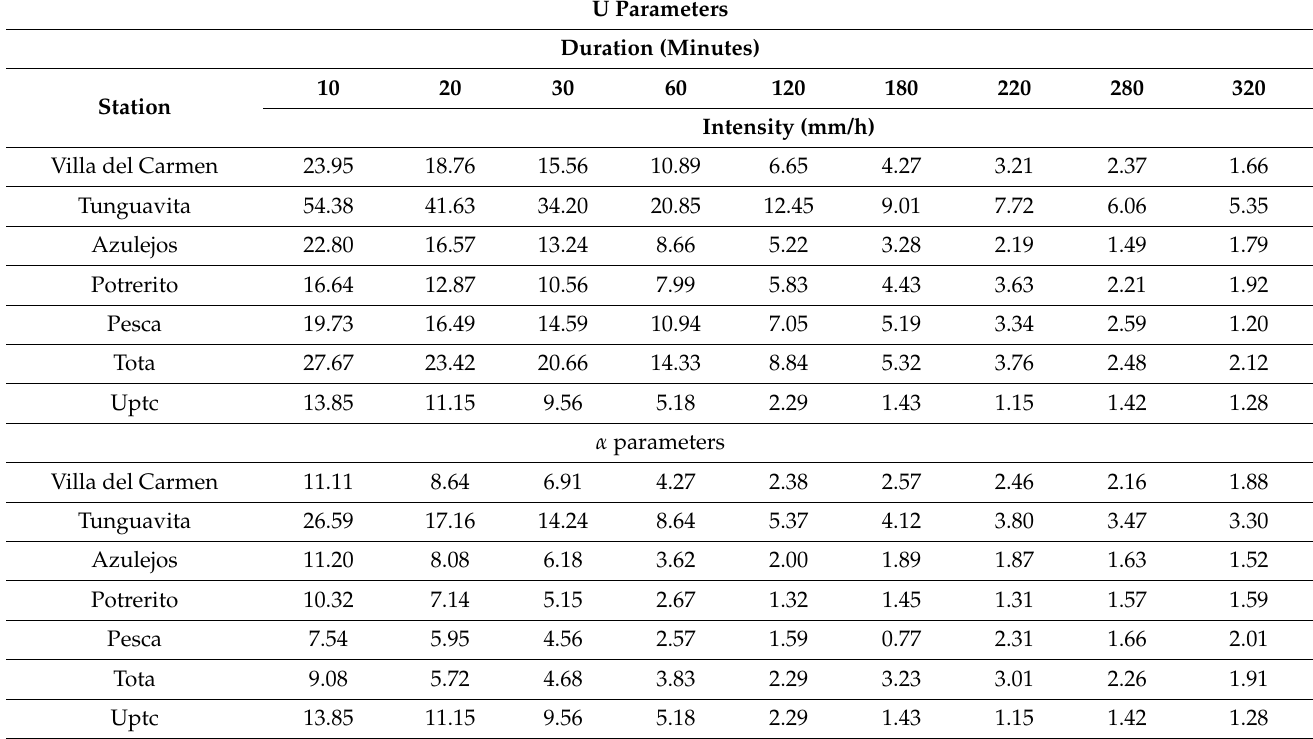
Table 4. u and α parameters for all stations. U